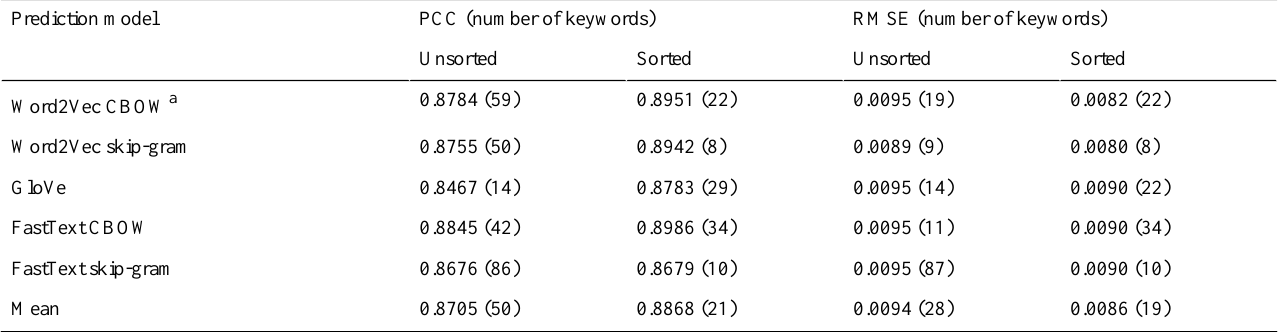
RMSE (number of keywords)PCC (number of keywords)Prediction model